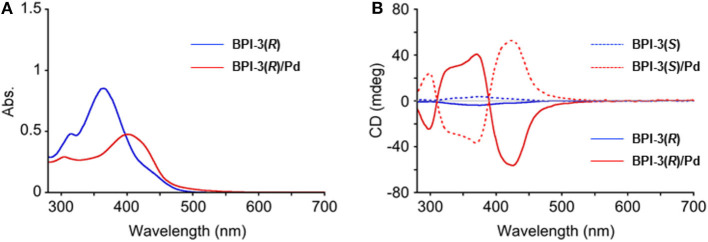
(A) UV-Vis absorption spectra of BPI-3(R) and BPI-3(R)/Pd polymer and (B) CD spectra of BPI-3(R), BPI-3(S), BPI-3(R)/Pd polymer, and BPI-3(S)/Pd polymer in CH2Cl2 at 25°C. [BPI-3] = 3.29 × 10−5 M, [BPI-3/Pd polymer (monomer)] = 3.11 × 10−5 M.